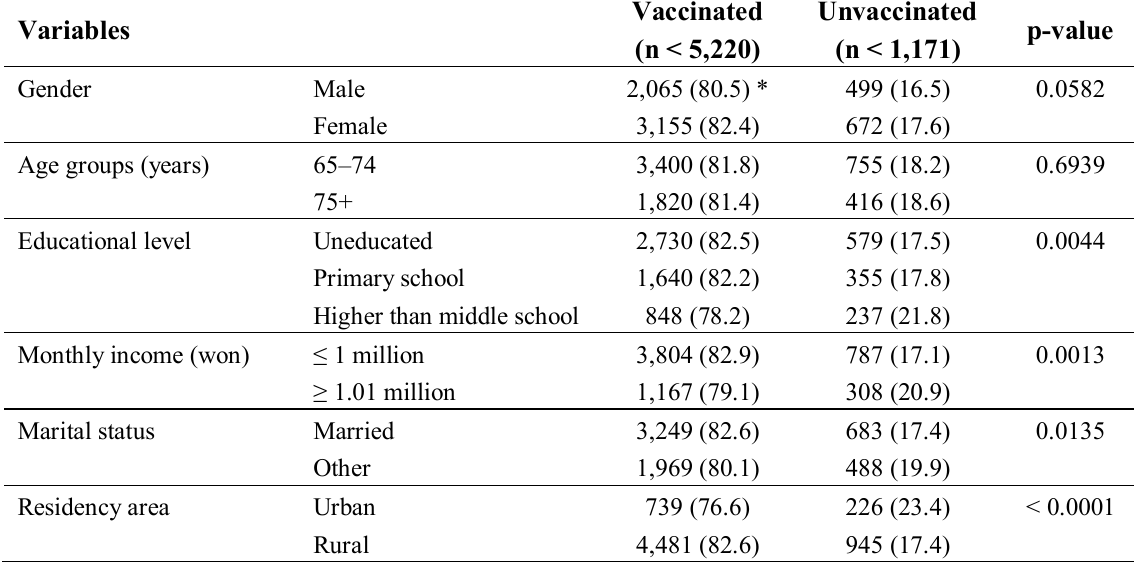
Table 3. Influenza vaccination coverage rates according to socio-economic